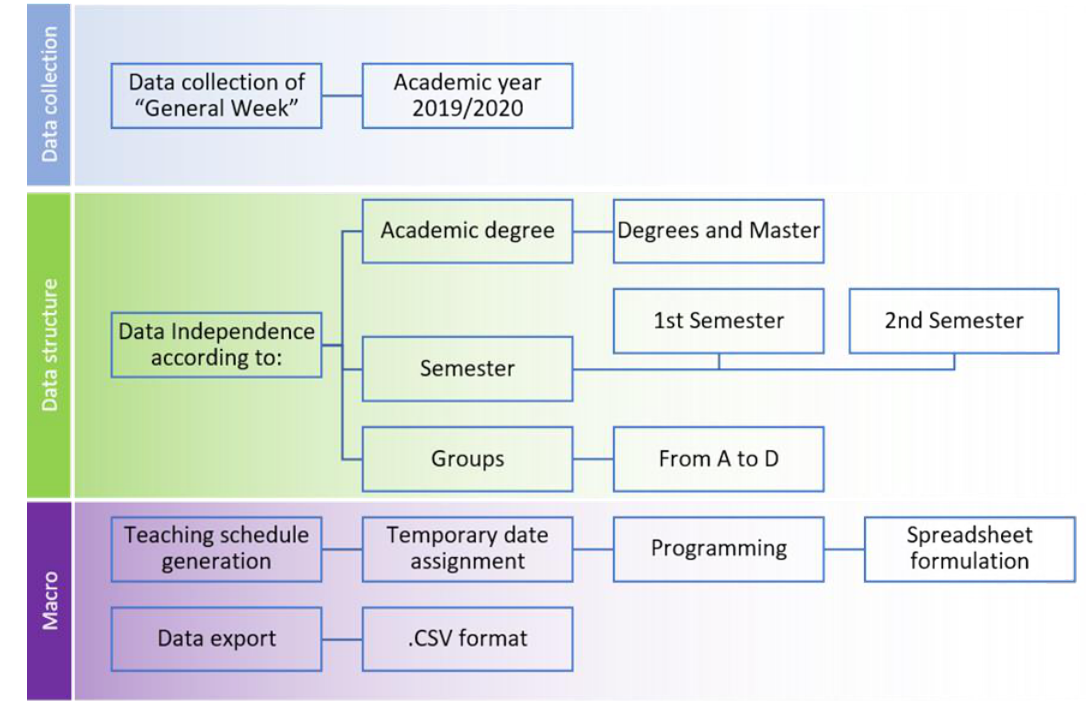
Figure 4. Scheduling digitalization and BIM model link.